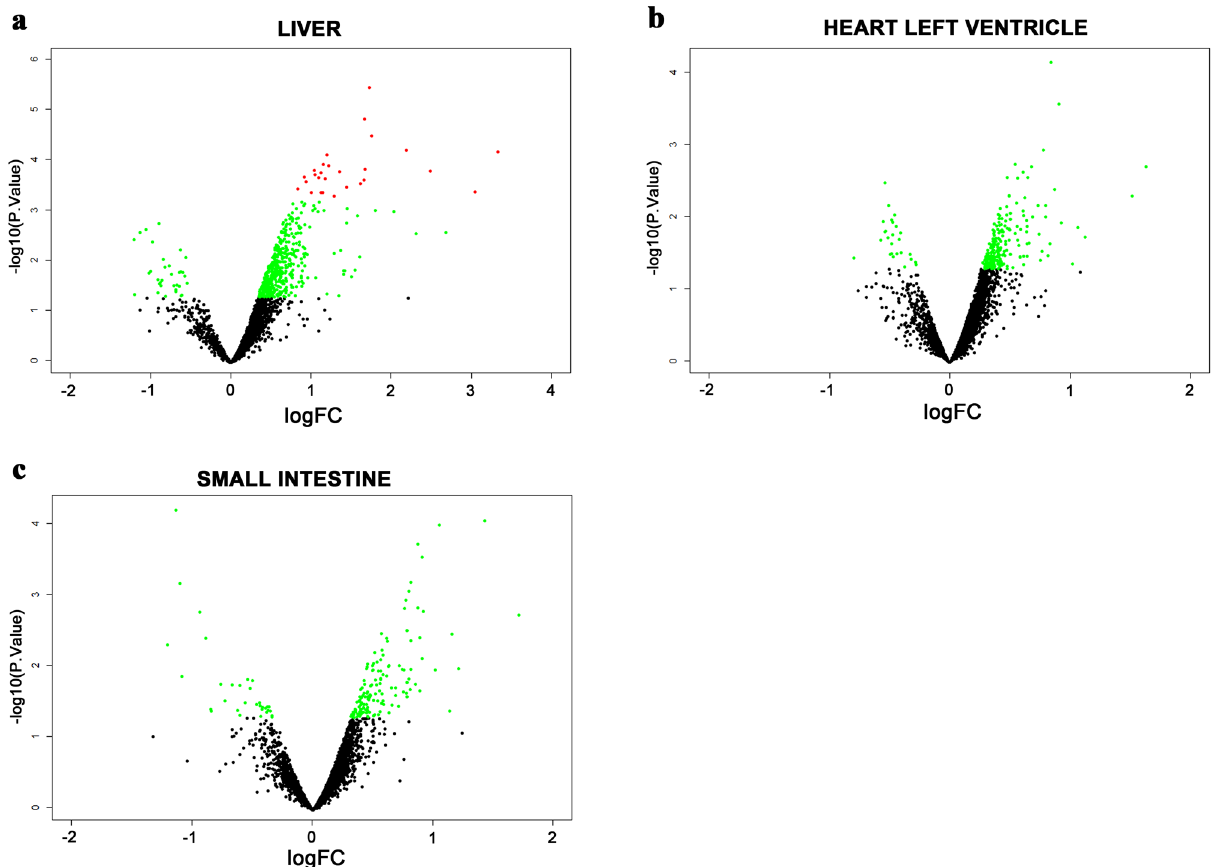
Figure 2. Volcano plots of miRNAs expression profiles in right lobe of the liver ( a ), left ventricle of the heart ( b ) and small intestine ( c ) from hyperlipidemic hamsters normalized to normolipidemic hamsters. The green spots